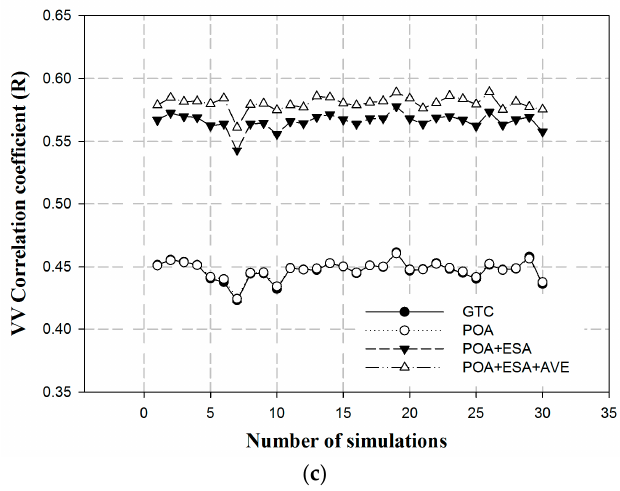
Figure 22. Uncertainties analysis related to LiDAR forest AGB. The correlation coefficient between backscattering coefficients and simulated forest AGB: ( a ) HH; ( b ) HV; ( c ) VV.